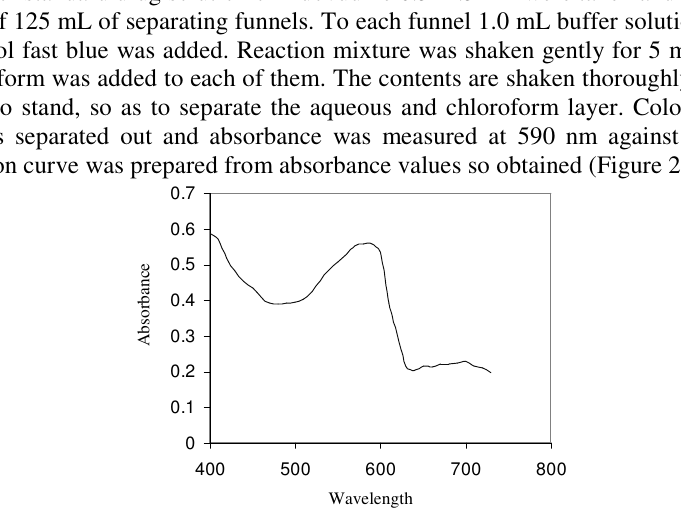
Figure 2. Absorption spectrum of zidovudine with wool fast blue at 590